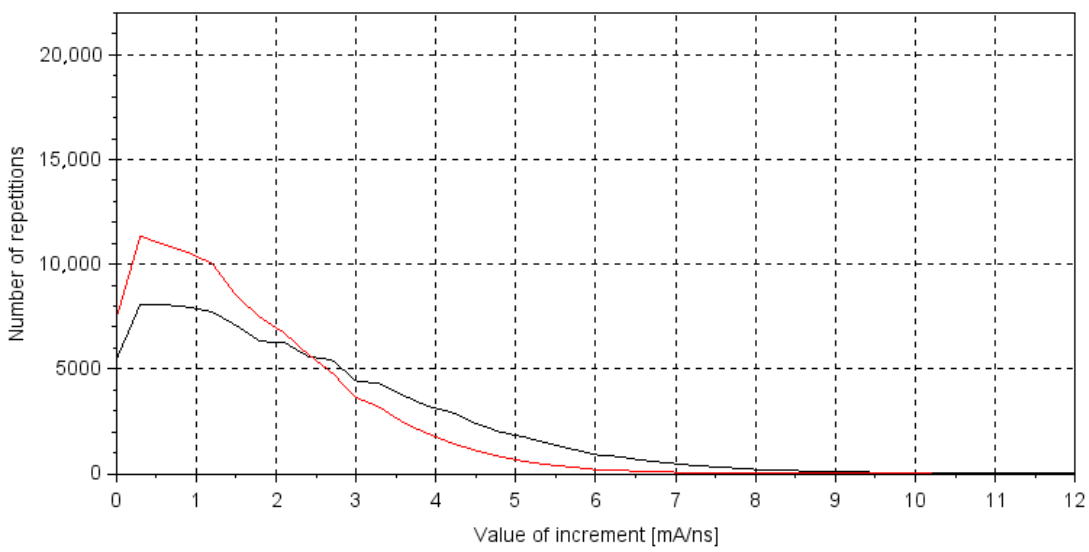
Figure 10. Figure showing 100 kpts decompositions of signals at different distances of electrodes, with 1 mm (black) and 1 cm (red) (conditions: voltage of 1.6 kV DC and current of 1 A DC at each measurement).